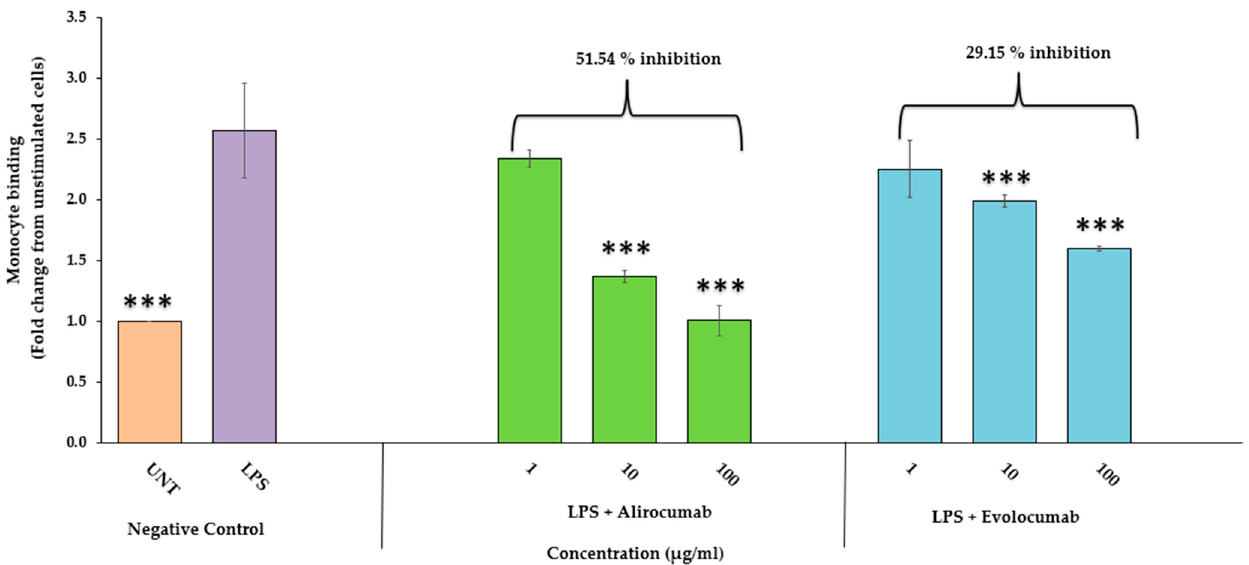
Figure 6. Effects of PCSK9 inhibitors (1–100 µg/mL) on monocyte-endothelial cell binding assay by LPS-stimulated HCAEC. Data are expressed as mean ± SD (n = 9). Statistical analysis: ANOVA, post-hoc with Bonferroni correction; *** p < 0.001 compared to HCAEC incubated with LPS alone. Abbreviation: UNT (Untreated), LPS (Lipopolysaccharide).